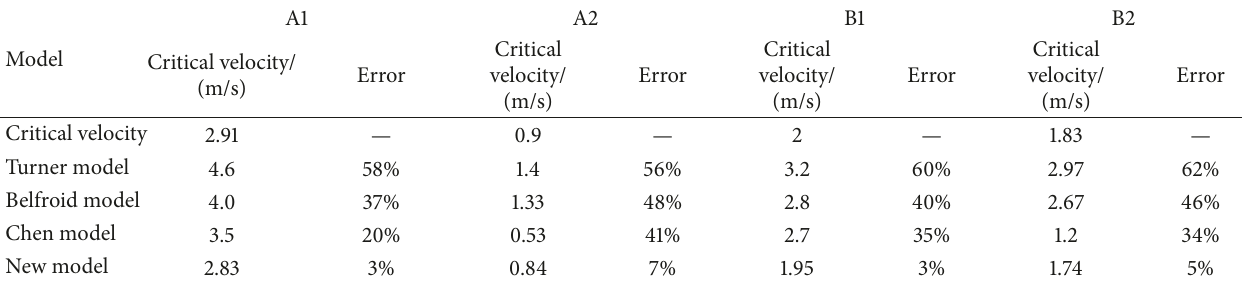
Table 6: Calculated results of different